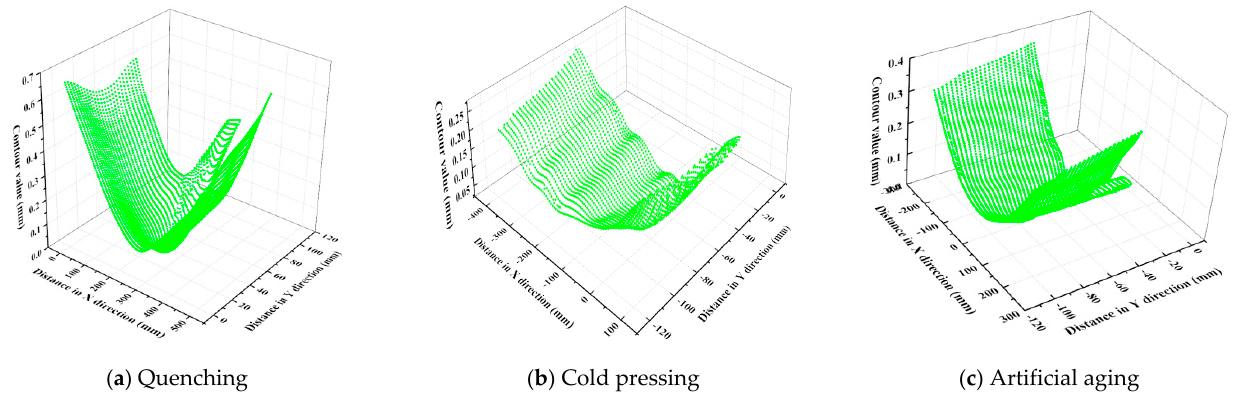
Figure 10. Contours of the cutting surface of the T-type rib after different processes: ( a ) quenching; ( b ) stepwise cold pressing; ( c ) artificial aging.